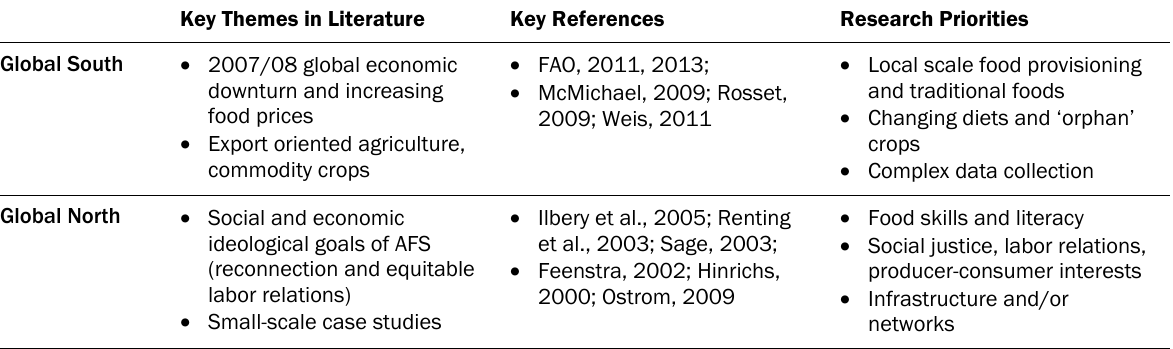
Figure 1. Summary of Key Research Themes and Priorities Key Themes in